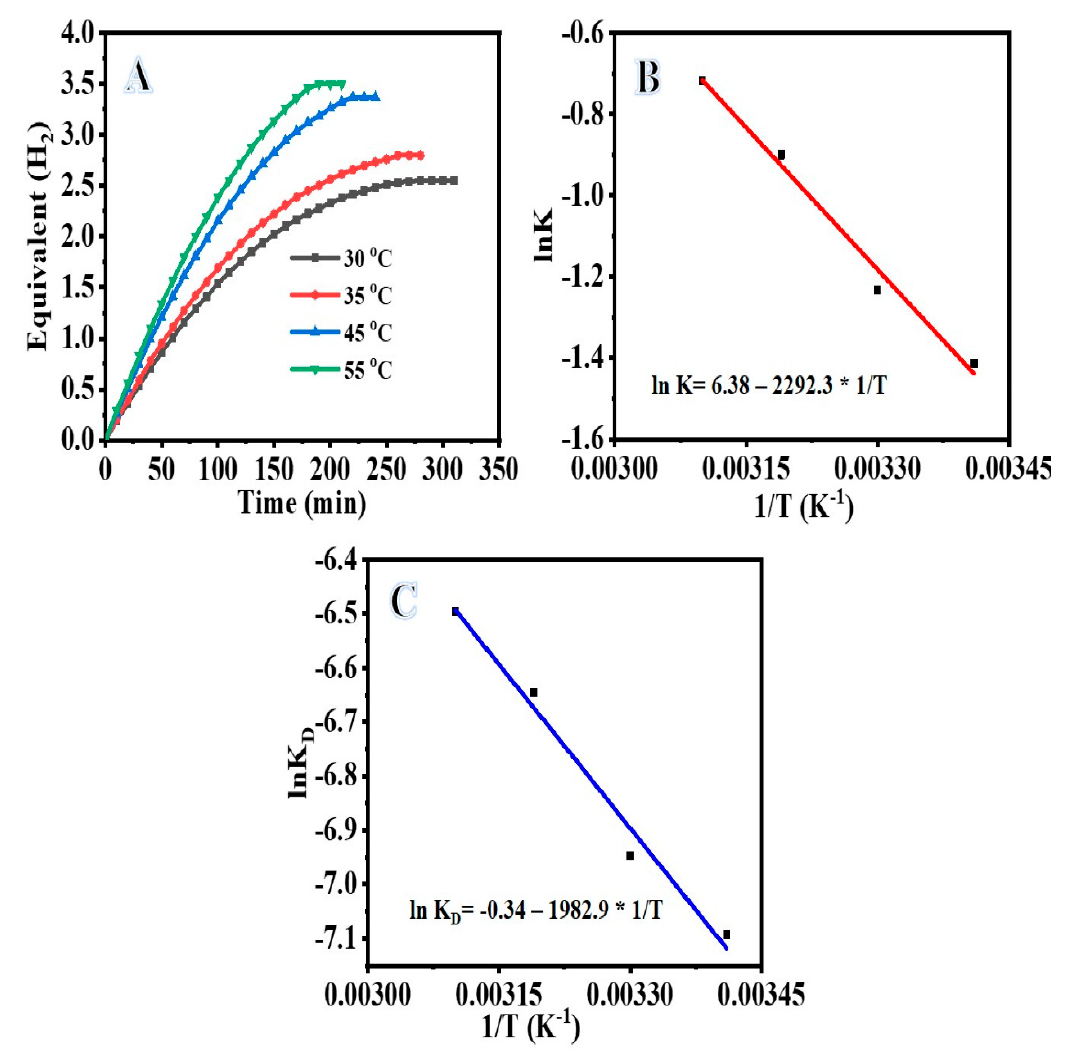
Figure 7. ( A ) Effect of NaBH 4 concentration on the catalytic performance; ( B ) plot of logarithmic of hydrogen generation rate vs. [NaBH 4 ].